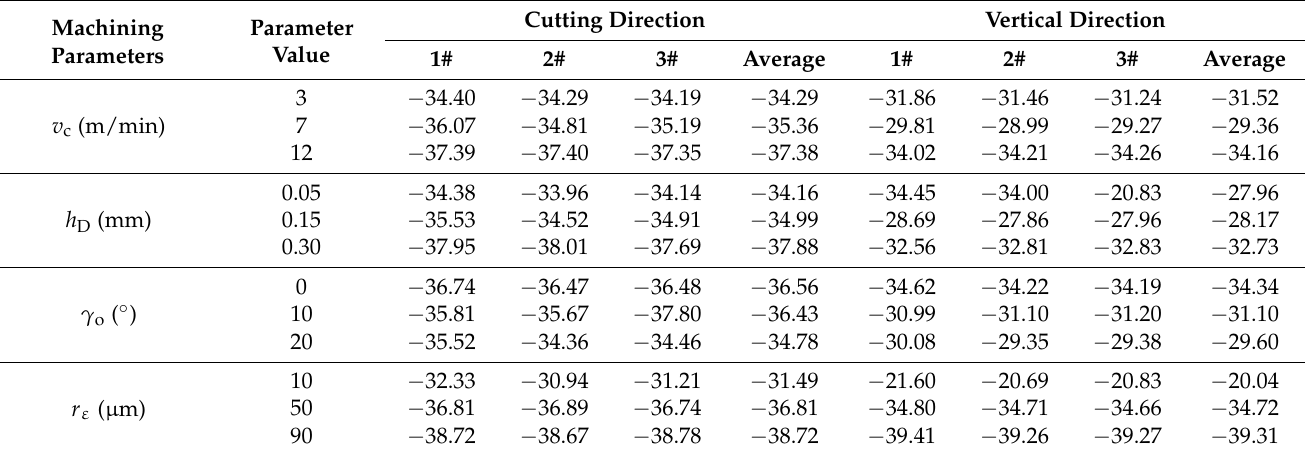
Table 4. Signal-to-noise ratio of machined surface